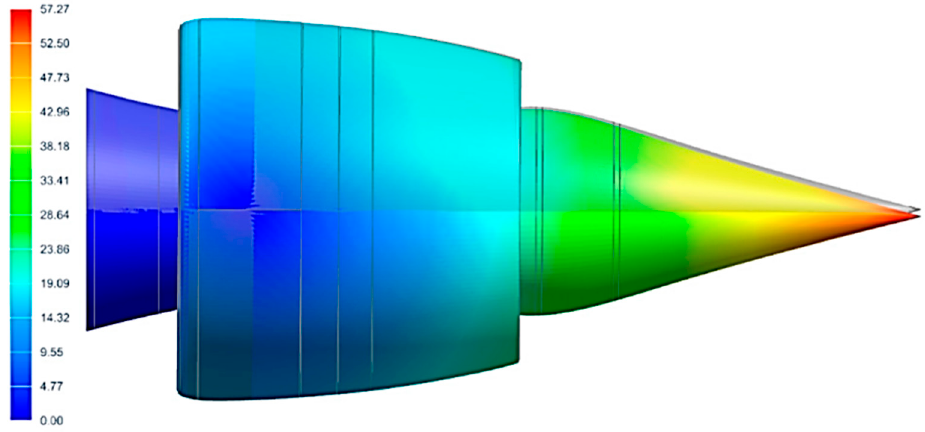
Figure 15. Displacement map for fuselage nacelle and integration structure under load. Reprinted with permission from [147]. 2021, MDPI.